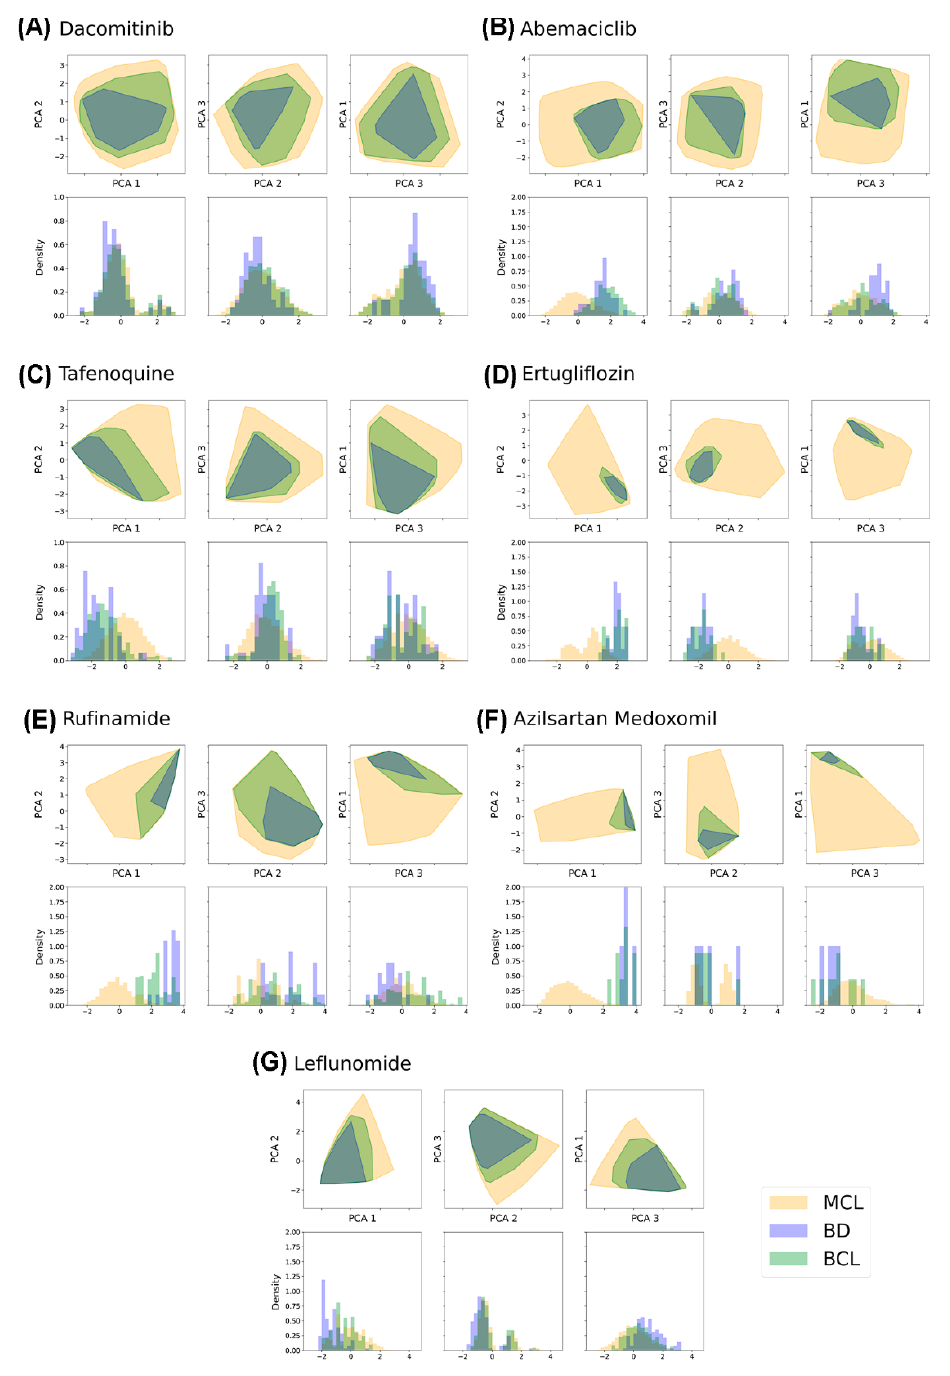
Figure 2. For each subfigure, in the first row, there is the graphical representation of the scatter plot contour of MCL (pale yellow), BD (blue) and BCL (green) libraries when projected on PC1-PC2 (left), PC2-PC3 (middle) and PC3-PC1 (right) planes. In the second row, we show the density histogram for the considered libraries along PC1 (left), PC2 (middle) and PC3 (right). This scheme is repeated for all patents: ( A ) Dacomitinib, ( B ) Abemaciclib, ( C ) Tafenoquine, ( D ) Ertugliflozin, ( E ) Rufinamide, ( F ) Azilsartan Medoxomil and ( G ) Leflunomide.